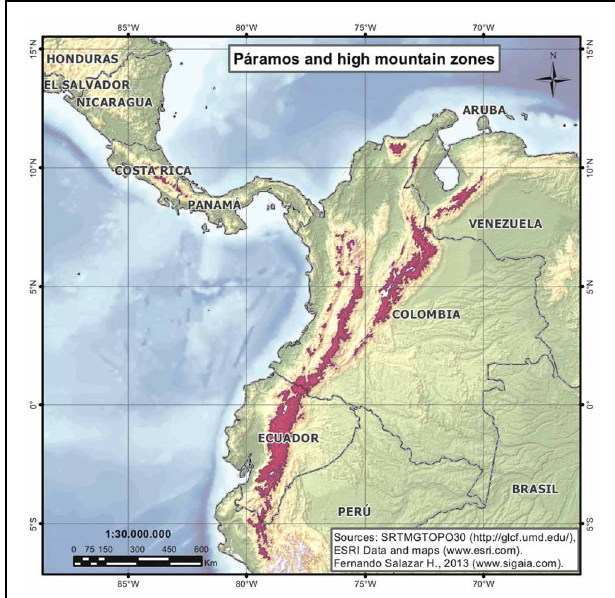
FIGURE 1 | Map indicating the present day area covered by Páramos (light